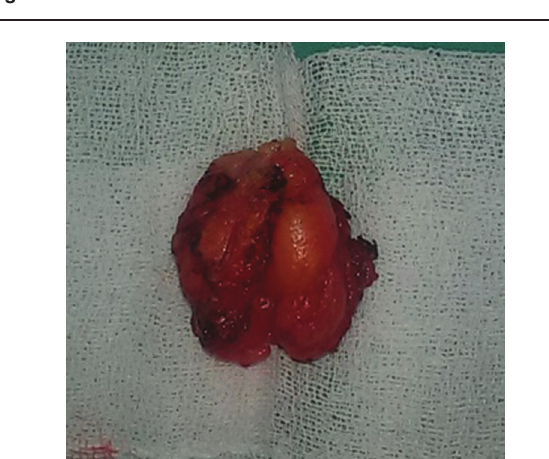
MRI, T1 weighted image of Neck shows high signal